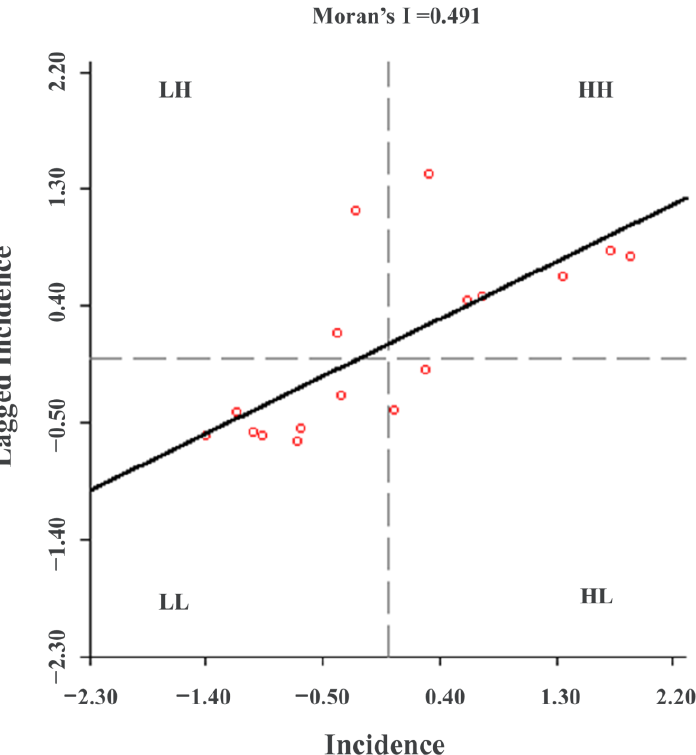
Figure 3. The global Moran’s I spatial autocorrelation analysis of the incidence of digestive tract cancer in Lujiang County from 2012 to 2017. Six high-high agglomeration areas (HH) and seven low-low agglomeration areas (LL) were found using global Moran’s I. (Note: HH stands for high-high agglomeration area, LH stands for low-high agglomeration area, LL stands for low-low agglomeration area, and HL stands for high-low agglomeration area).